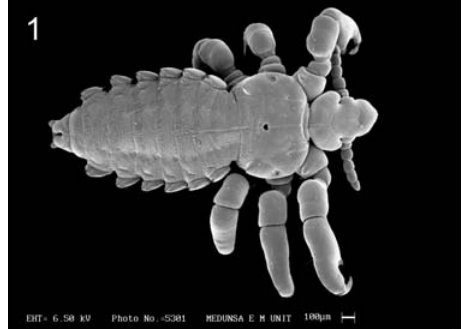
Fig. 1. A SEM micrograph of the dorsal view of Heamatopinus bufali